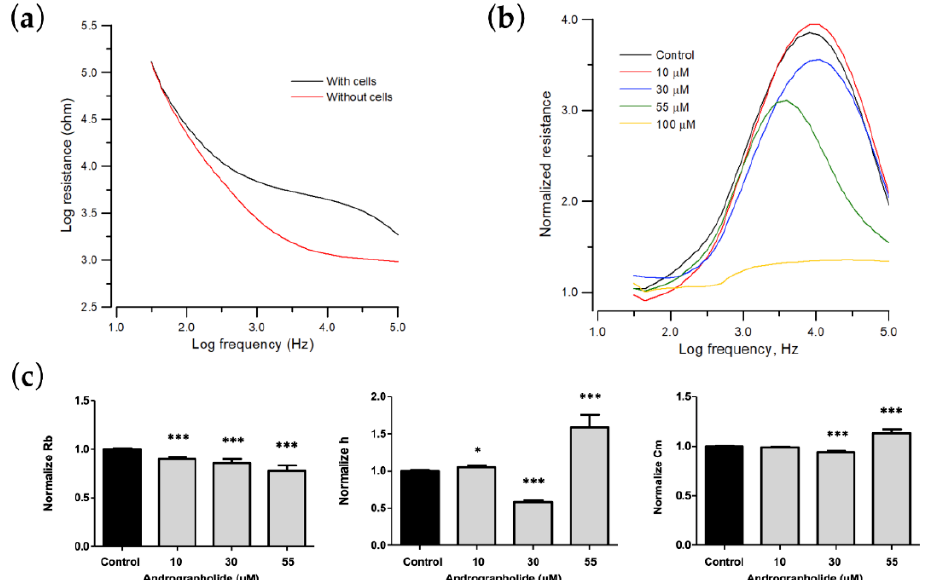
Figure 3. Change in morphological parameters of confluent OEC-M1 cells layers after challenge with different concentrations of andrographolide. ( a ) Resistance data as a function of frequency for cell-free (red line) and cell-covered (black line) electrodes. ( b ) Normalized resistance curves as a function of frequency using a frequency-scan measurement 24 h after the addition of andrographolide to confluent OEC-M1 cell layers at concentrations of 10 µ M (red), 30 µ M (blue), 55 µ M (green), 100 µ M (yellow), and control (black). ( c ) Changes in normalized junction resistance between cells, average cell–substrate separation, and membrane capacitance of confluent OEC-M1 cell layers after challenge with different concentrations of andrographolide. Six independent frequency scan experiments were performed ( n = 6). Two or three wells were measured for each drug concentration for each experiment. Values are shown as means ± SEM. * p < 0.05, *** p < 0.001. Each value is expressed as a percentage of the